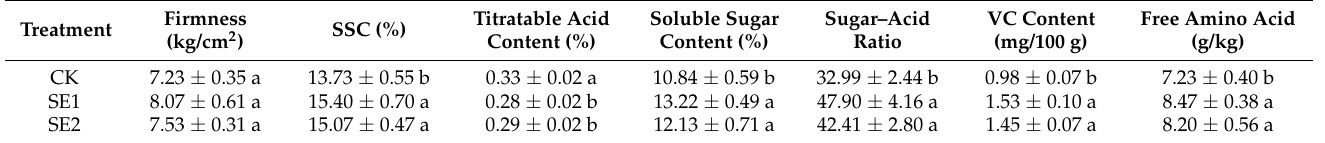
Table 3. Effects of organic fertilizer on the internal quality of apple fruit.